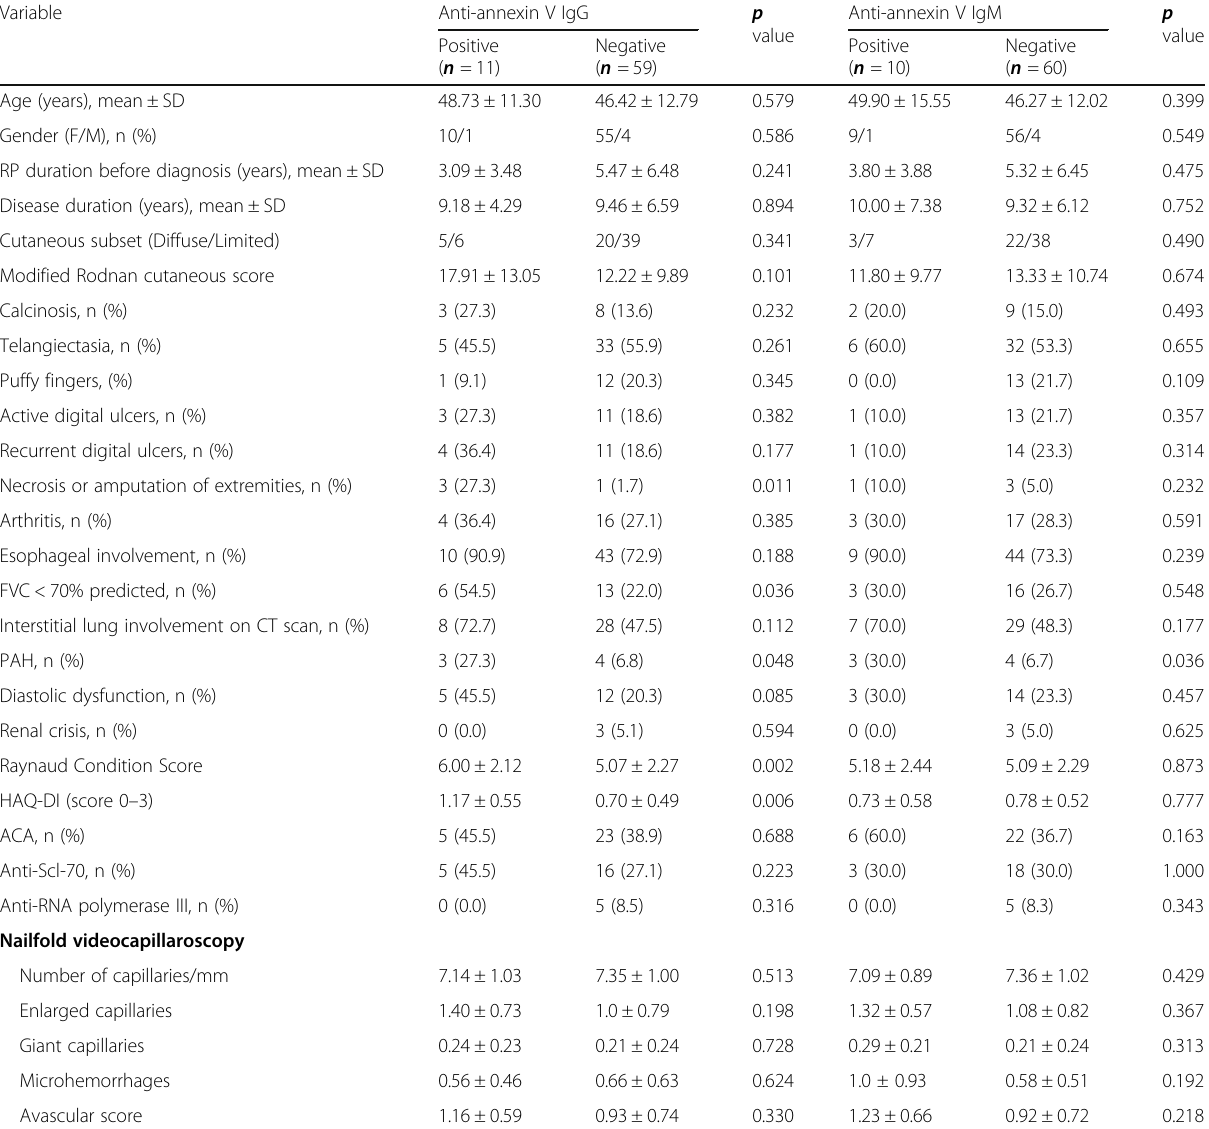
Table 3 Clinical variables according to the presence or absence of anti-annexin V at baseline